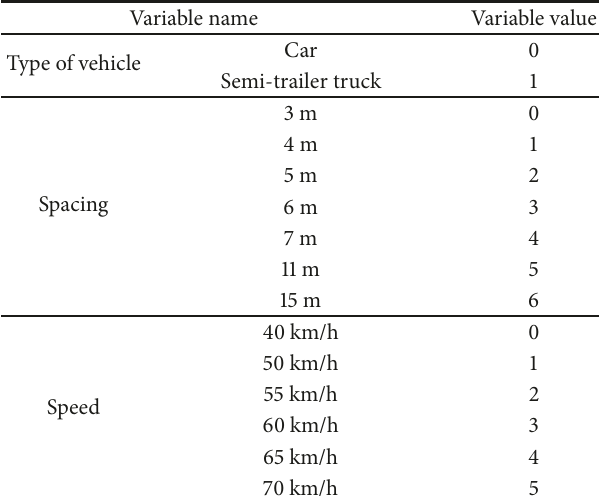
Table 4: The classification of each